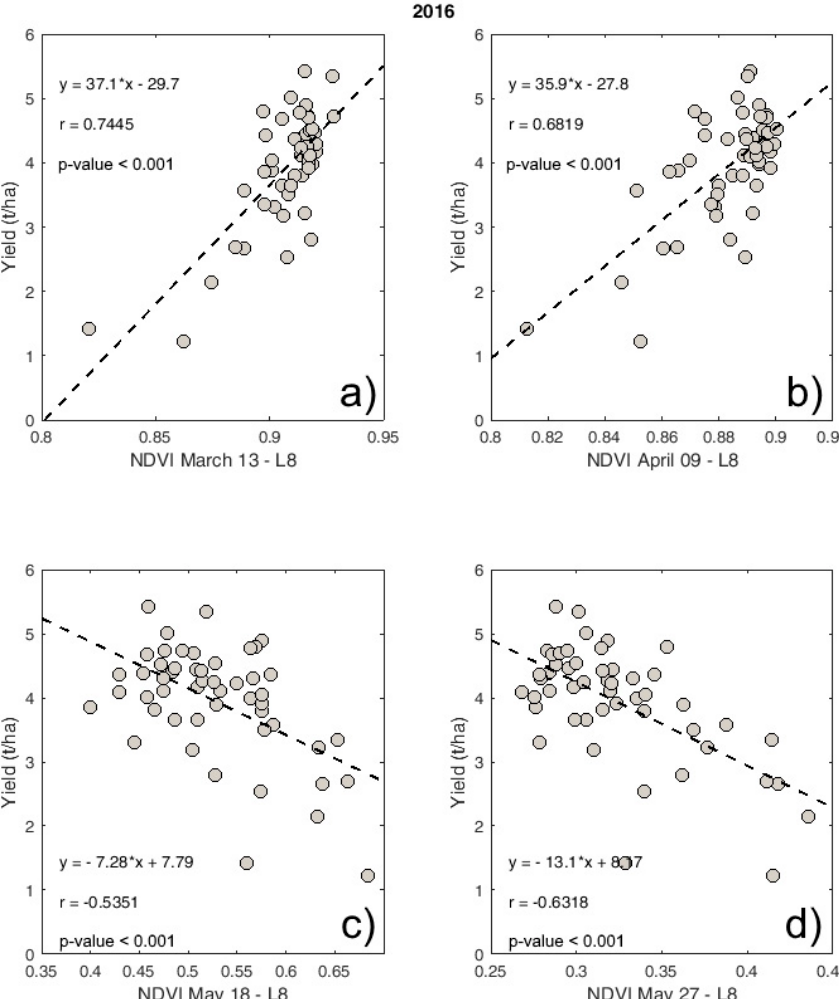
Figure 6. Relationship between observed yield (yield monitor) and NDVI (Landsat-8) for 2015–2016 crop season in ( a ) 13 March, ( b ) 9 April, ( c ) 18 May and ( d ) 27 May.